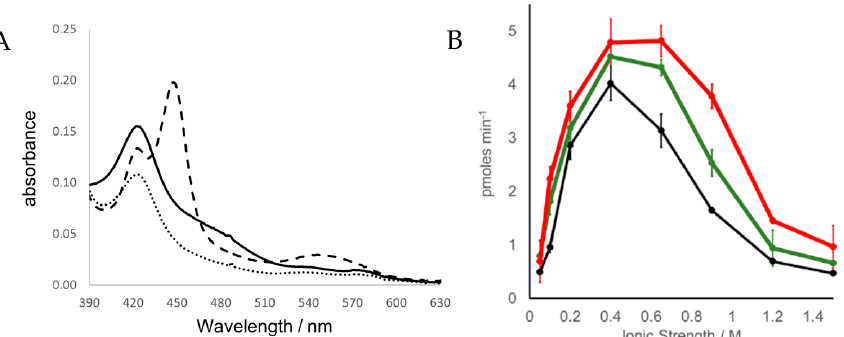
Figure 1. ( A ) CO binding assays of ARO-BMR chimeras. Oxidized, reduced, and CO bound spectra are shown in solid, dotted, and dashed lines, respectively for ARO-BMR. ( B ) Ionic strength dependence of ARO-BMR chimeras’ activity. Activities of ARO-BMR, ARO-BMR-3GLY, and ARO-BMR-5GLY are reported in black, green, and red respectively.